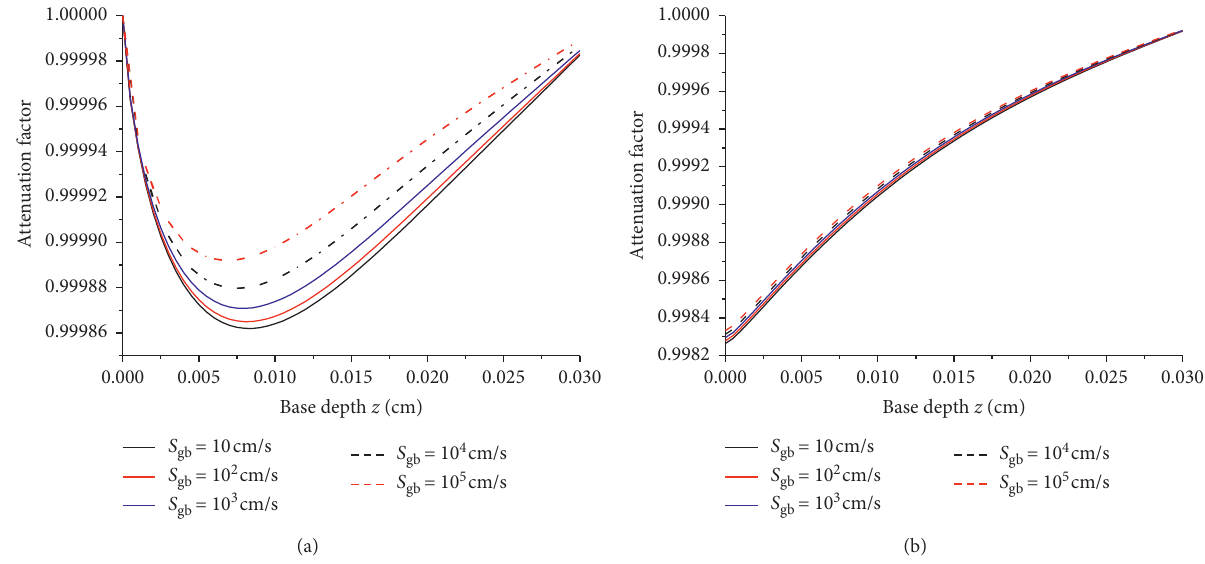
Figure 5: Attenuation factor of the electromagnetic wave versus base depth for different grain boundary recombination velocity in short circuit (a) and open circuit (b) ( g � g x � g y � 0.01cm).